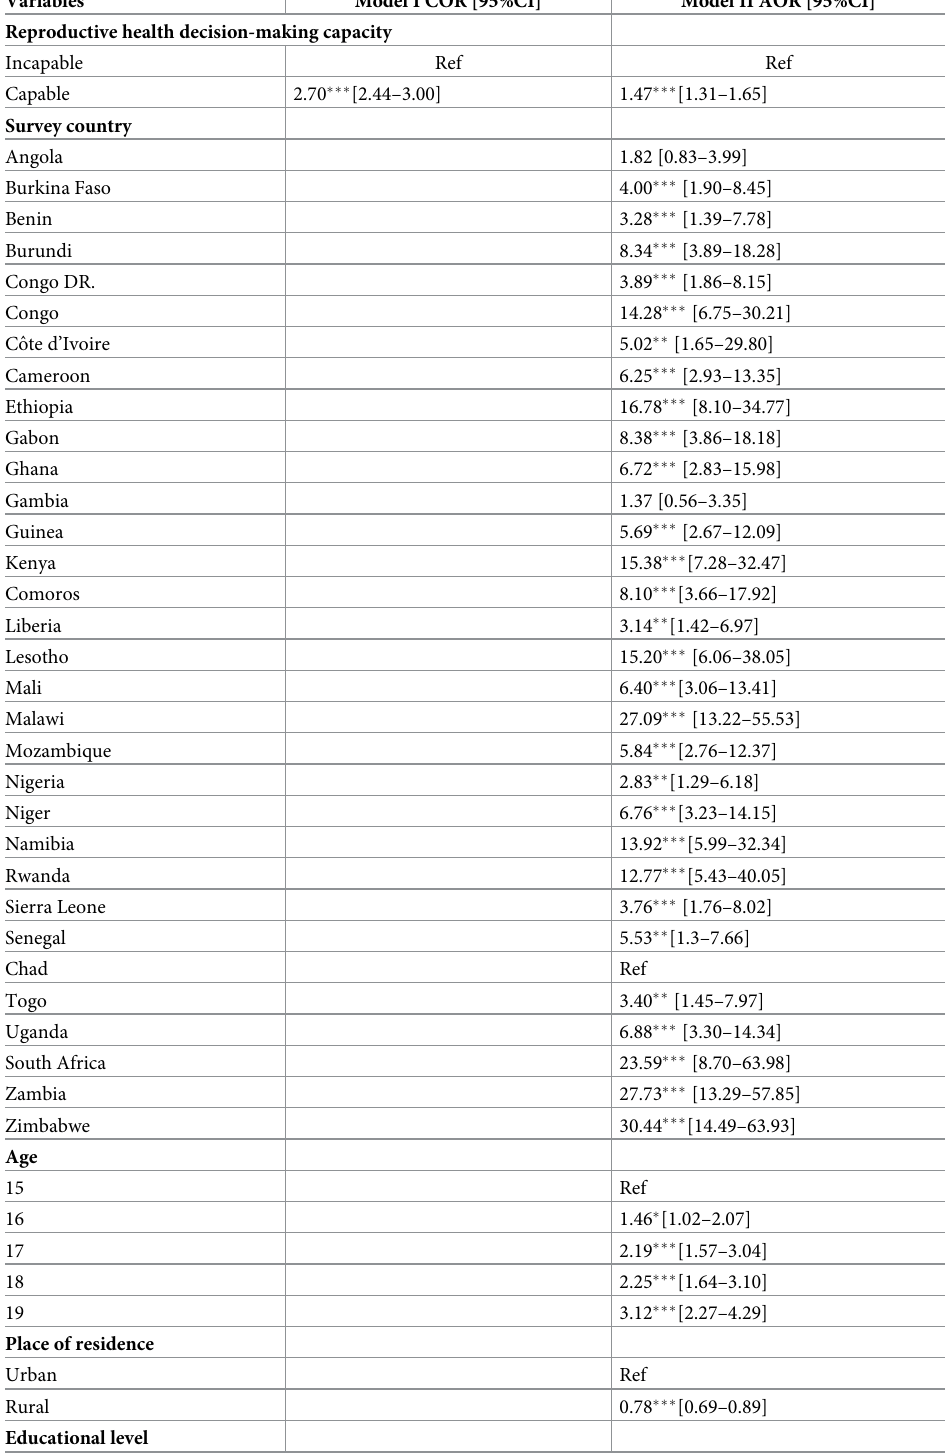
Table 3. Binary logistic regression analysis on female adolescents’ reproductive health decision-making capacity and contraceptive